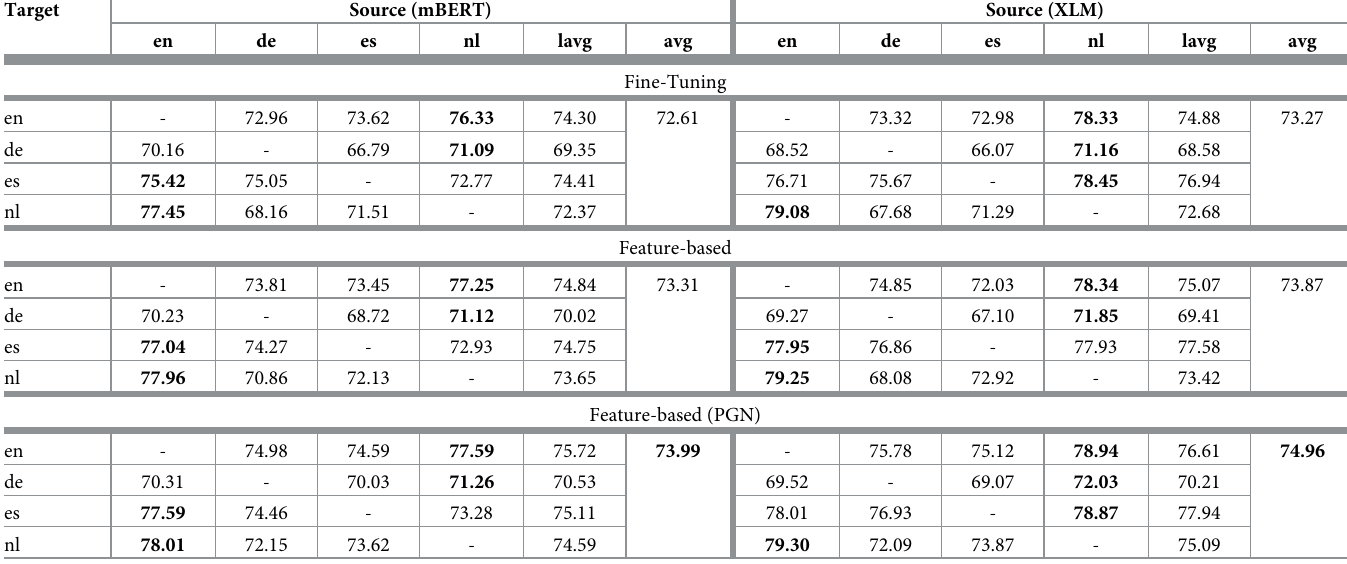
Table 2. Main results of single-source cross-lingual NER, where lavg indicates the averaged performance for each target language, and avg denotes the overall aver- age F-scores of all source-target pairs.